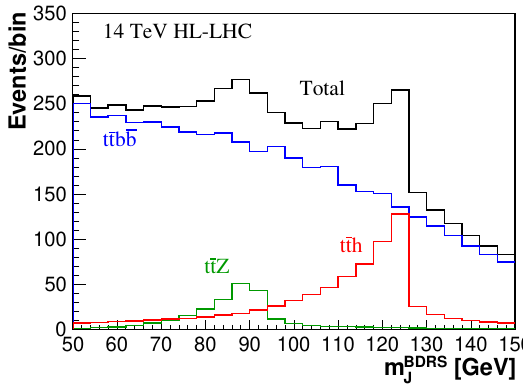
Figure 2 . The invariant mass distributions of signal and background for the BDRS tagged fat-jet m BDRS at the 14 TeV HL-LHC. We show t ¯ th signal (red), the t ¯ tb ¯ b (blue), and t ¯ tZ (green) in a non- J stacked format. The full stacked result is also presented (black). We assume 3 ab − 1 of integrated luminosity. For more details on the cut-flow analysis, see table 1.